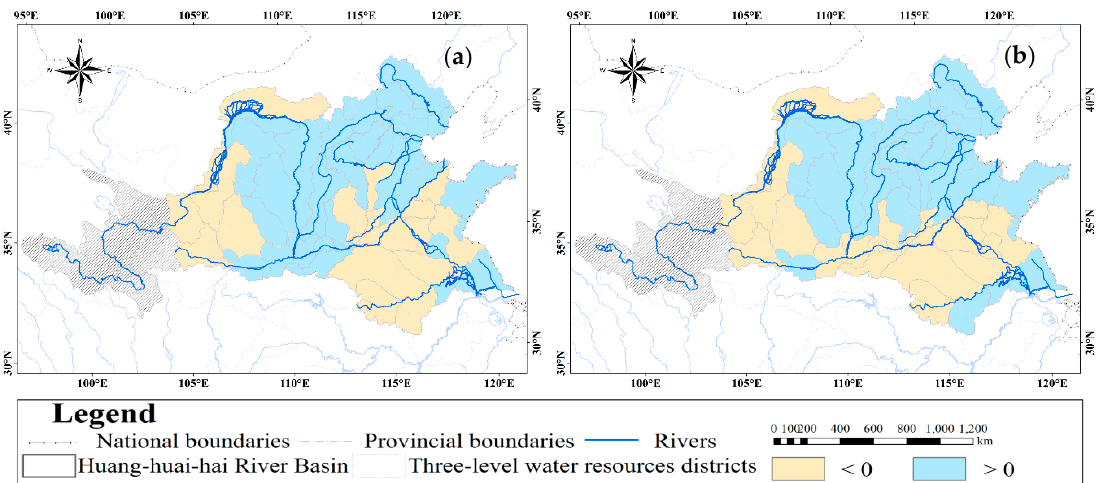
Figure 8. The difference between meteorological droughts and statistical droughts in: RDAA ( a ); and RDSA ( b ).